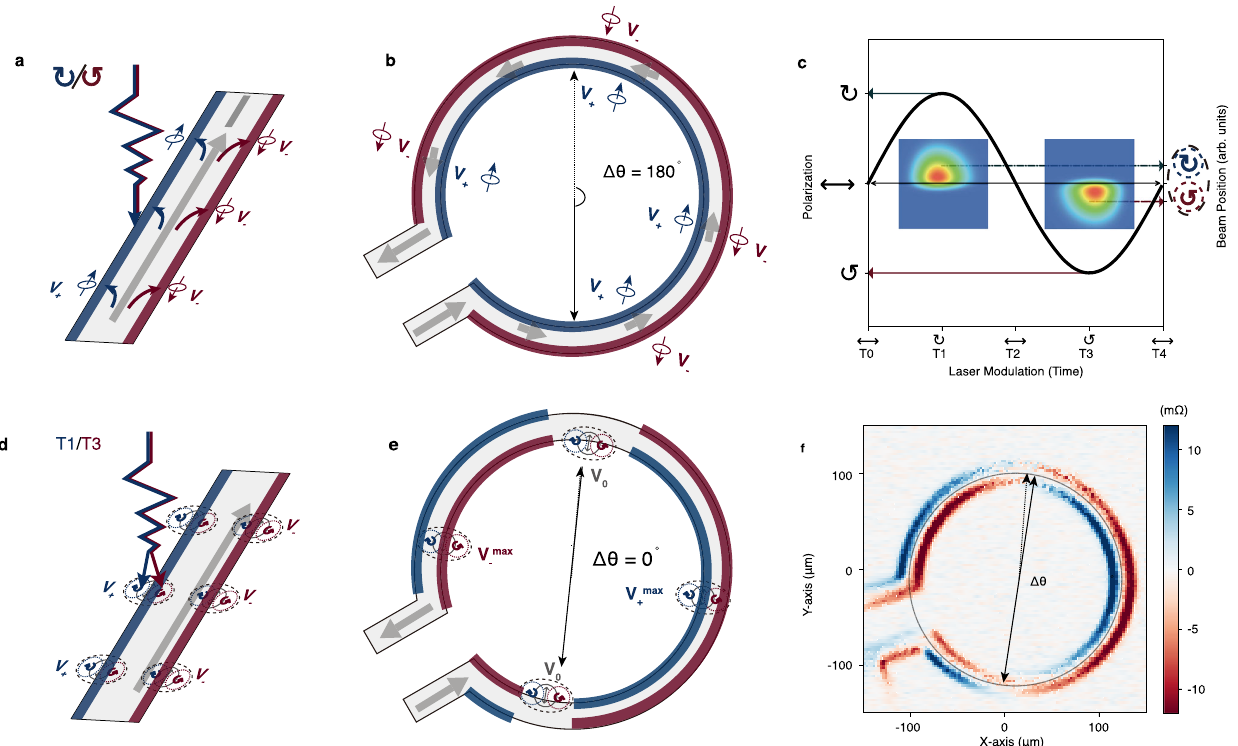
Fig. 1 | Spin accumulation induced photoresistance and beam shift induce photoresistance. Illustration of spin accumulation and the corresponding helicity dependent photoresistance detected for a a straight current path and b a ring shaped current path. The up/down spin accumulation appears at the edges of the device on the left/right side of the electric current. Thus, when illuminated by a circularpolarizedlight,theabsorptionofoneparticularcircularly-polarizedlightis different for spin-up and spin-down. The longitudinalresistance of the illuminated area on one edge will exhibit a higher value (blue) when illuminated with one particular helicity light, while on the other edge will be lower (red). c Cartoon illustrationofthelaserspotbarycenterdisplacementassociatedtothepolarization change from circular left (T1) to circular right (T3). The beam shift effect is illu- strated by the two dashed circles the right y-axis, indicating the beam center positionsaredifferentatT1andT3.Anexampleoftwolaserspotpro fi lessimulated